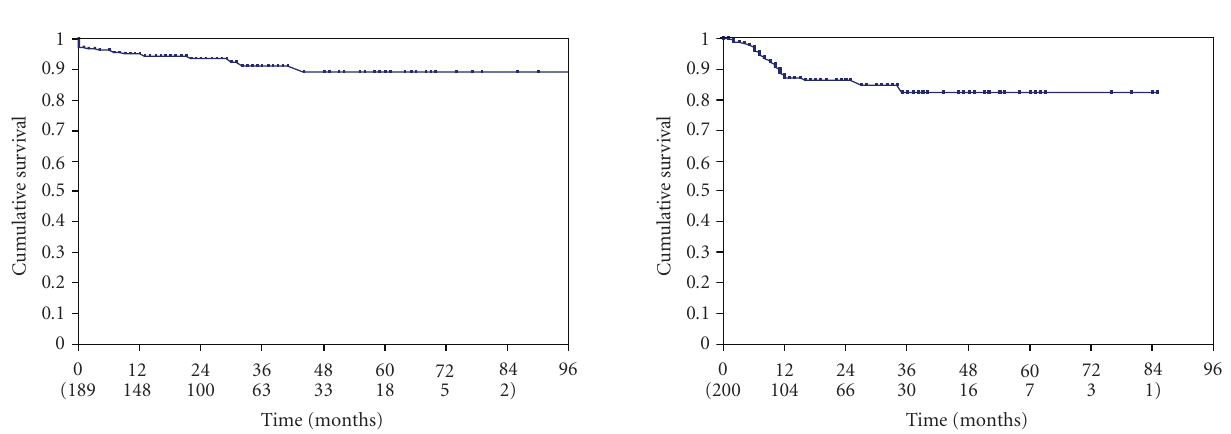
Figure 1: Kaplan Meyer analysis curve of the cumulative freedom from stroke and death.